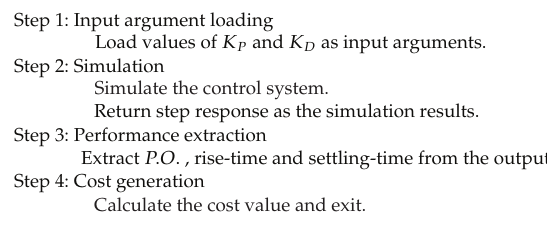
Figure 13: The objective function procedures for the control problem.